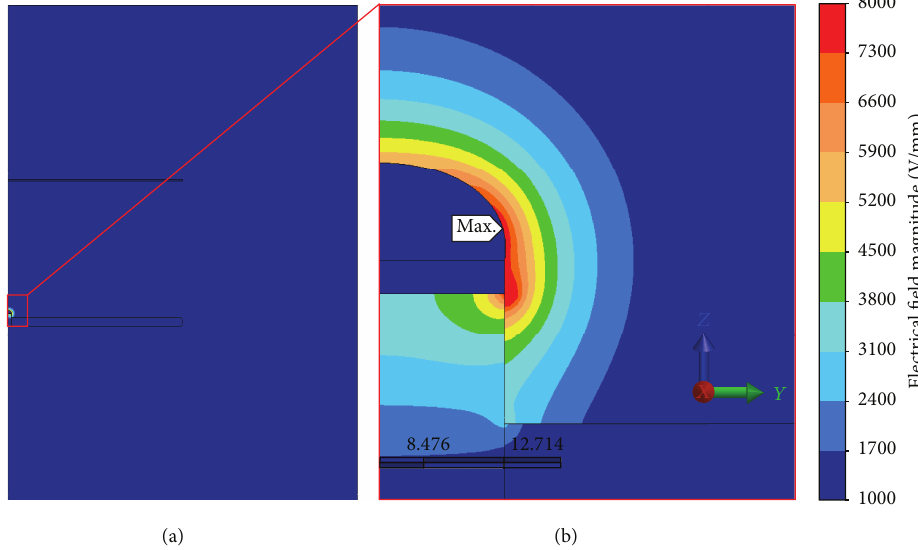
Figure 7: (a) Spatial distribution of electrical field strength and (b) detailed view on the tip of the rod electrode.